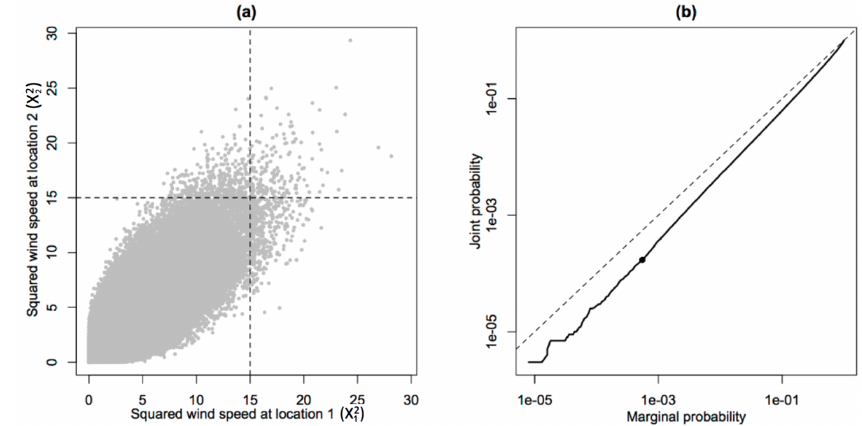
Figure 11. Simulation of wind speeds at two sites having highly correlated velocities (see main text for details): (a) scatter plot of squared wind speeds at the two sites (1000 points randomly sampled out of the million); (b) joint versus marginal exceedance probabilities (on logarithmic axes). The dot shows an example obtained by counting the fraction of points in the upper right and the right-hand quadrants of (a) . The curve has a steeper slope than the dashed line (equal probabilities denoting complete dependence), suggesting asymptotic